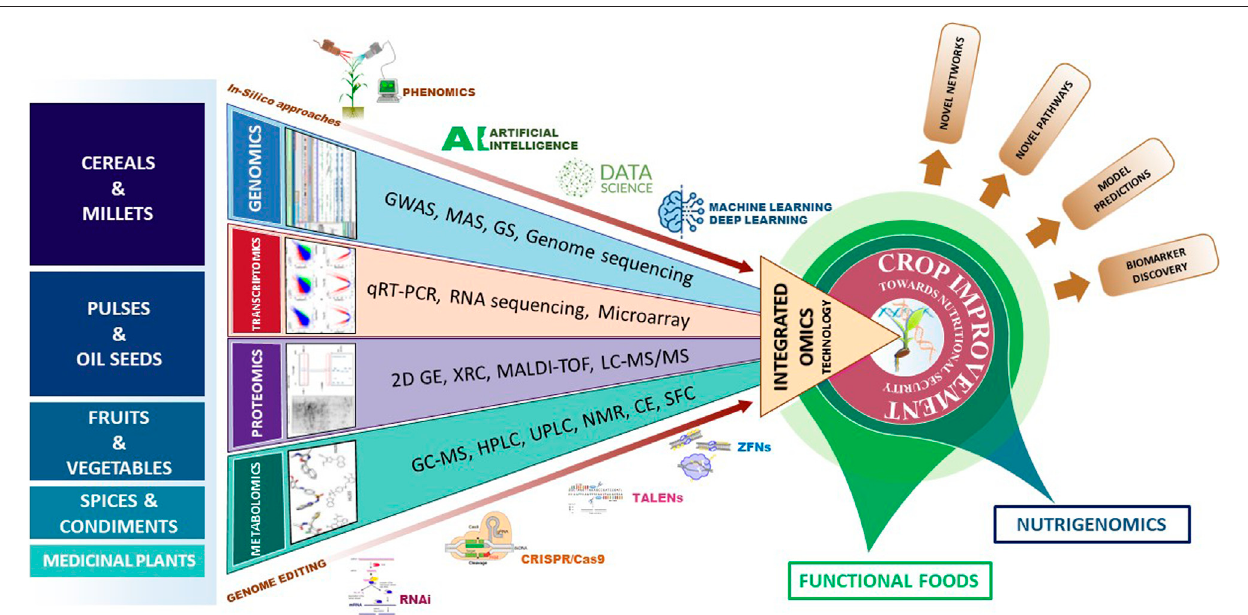
FIGURE 2 | Integrated omics approaches for enhancing functional foods. In this fi gure, the crop categories speci fi ed are orderly arranged in descending manner with respect to the utilization of omics technologies to improve functional foods. Abbreviations: GWAS, Genome-Wide Association Studies; MAS, Molecular Assisted Selection; GS, Genomic Selection; qRT-PCR, Quantitative Real Time polymerase Chain Reaction; 2D GE, 2-Dimensional Gel electrophoresis; XRC, X-Ray Crystallography; MALDI-TOF, Matrix-Assisted Laser Desorption/Ionization-Time Of Flight; LC-MS/MS, Liquid Chromatography — Mass Spectrophotometry; GC- MS, Gas Chromatography — Mass Spectrophotometry, HPLC: High Performance Liquid Chromatography; UPLC, Ultra Performance Liquid Chromatography; NMR, Nuclear Magnetic Resonance; CE, Capillary Electrophoresis and SFC, Supercritical Fluid Chromatography; RNAi, RNA interference; TALENs, Transcription Activator- Like Effector Nucleases; ZFNs, Zinc Finger